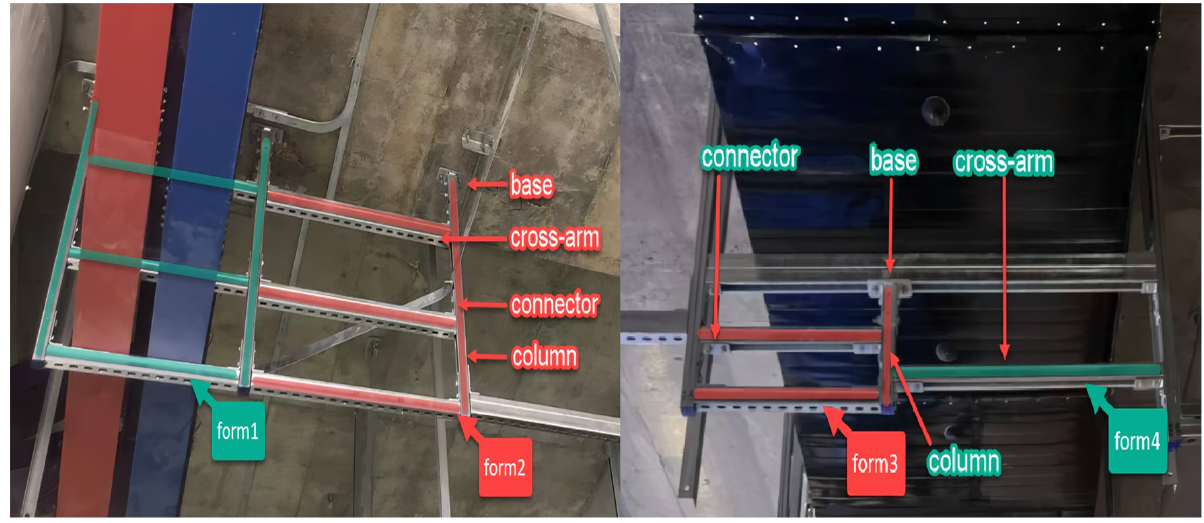
Figure 2. MEP hanger basic